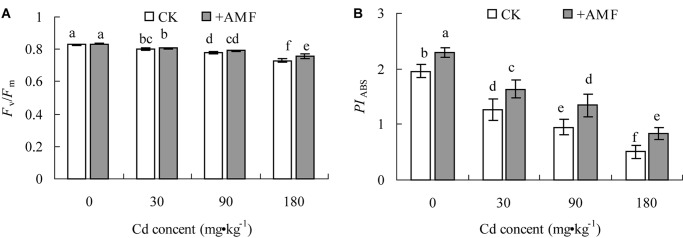
The effects of inoculation with G. mosseae on the Fv/Fm
(A) and PIABS
(B) of L. perenne leaves in cadmium contaminated soil. Different lowercase letters indicate a significant difference (P < 0.05) between the treatment and control.